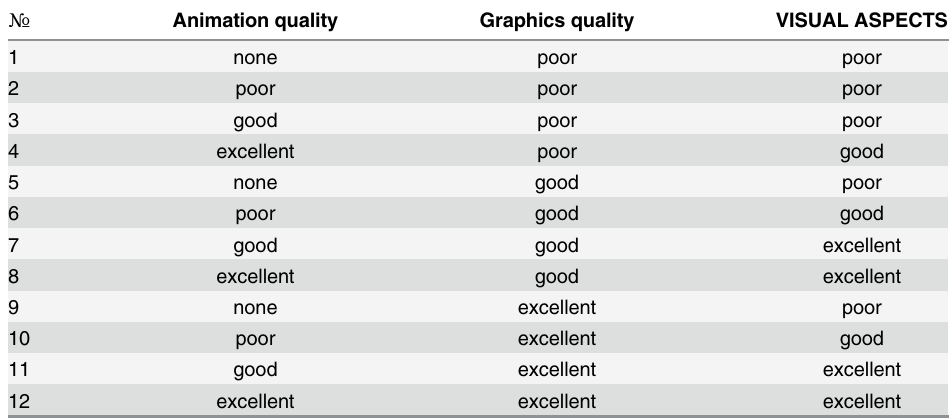
Table 3. Utility function for the attribute VISUAL ASPECTS